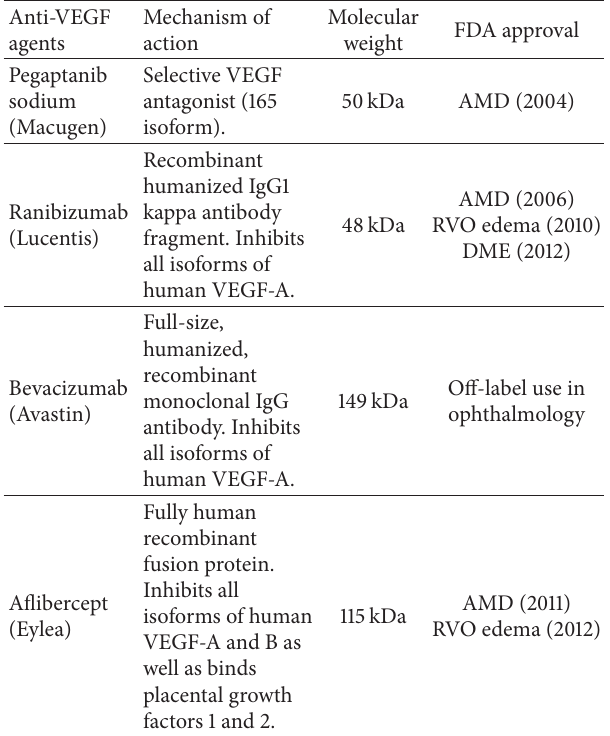
Table 1: Anti-VEGF